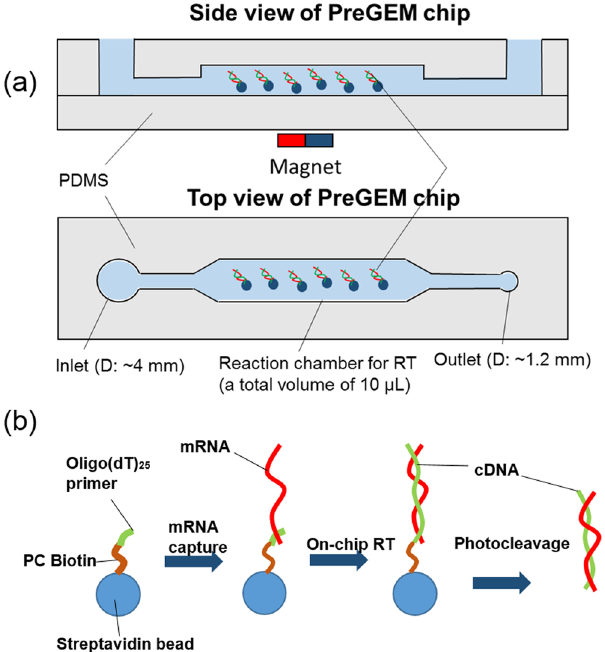
Figure 7. ( a ) Schematic of the side view of a PDMS PreGEM chip made by soft lithography. The microfluidic chip consists of an inlet for introduction of reagents, cell lysis and mRNA capture using magnetic beads as well as a reaction chamber for on-bead RT. ( b ) a bead-based process on the PreGEM chip: mRNA capture by